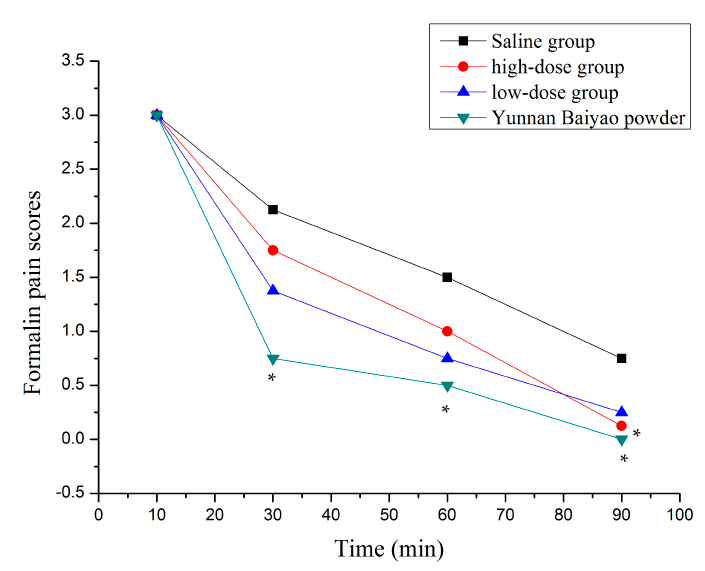
Figure 7. Time-effect curves of formalin pain scores (* p < 0.05 compared with saline group).